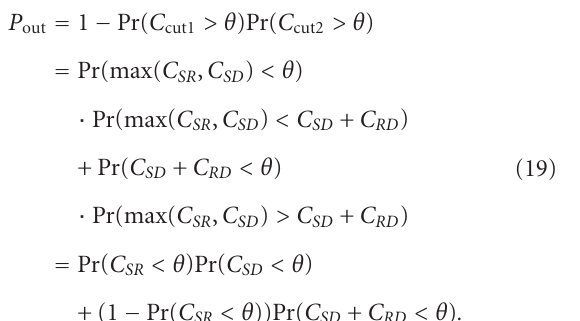
Figure 3: Ergodic capacity versus the location of the relay, E s = 1, N 0 = 1, l y = 0 . 5, and l SD = 1.